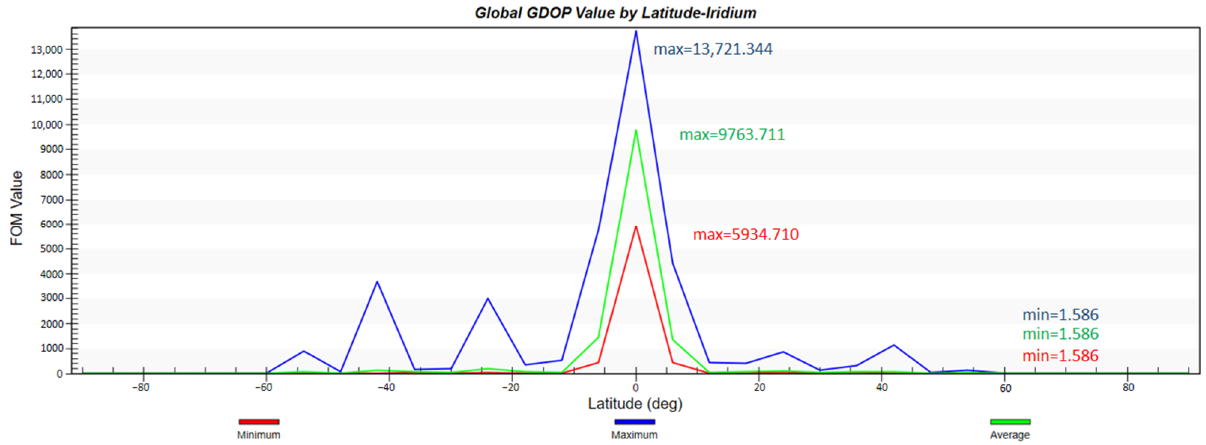
Figure 10. Global GDOP by latitude of Iridium constellation.